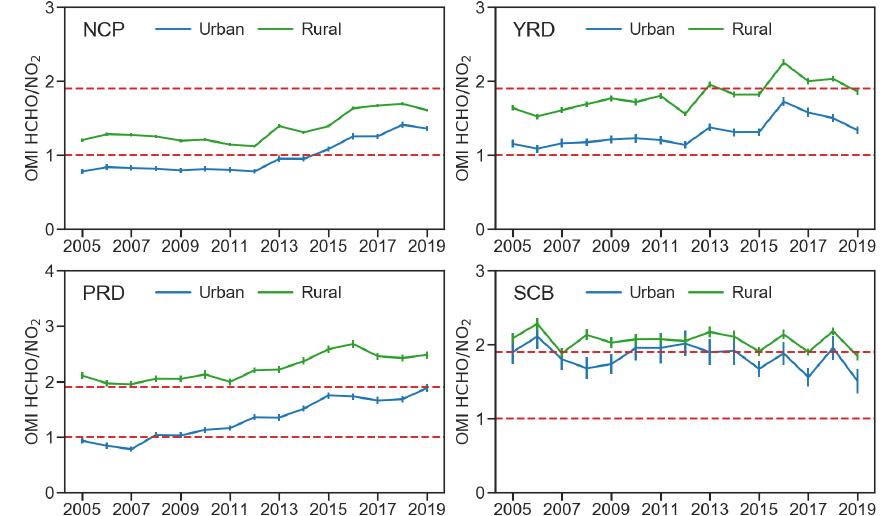
Figure 11. The temporal variations in HCHO / NO 2 from 2005 to 2019 in the NCP, YRD, PRD, and SCB. The two dashed red lines indicate the threshold values of 1.0 and 1.9, which separate the NO x -limited, transitional, and VOC-limited